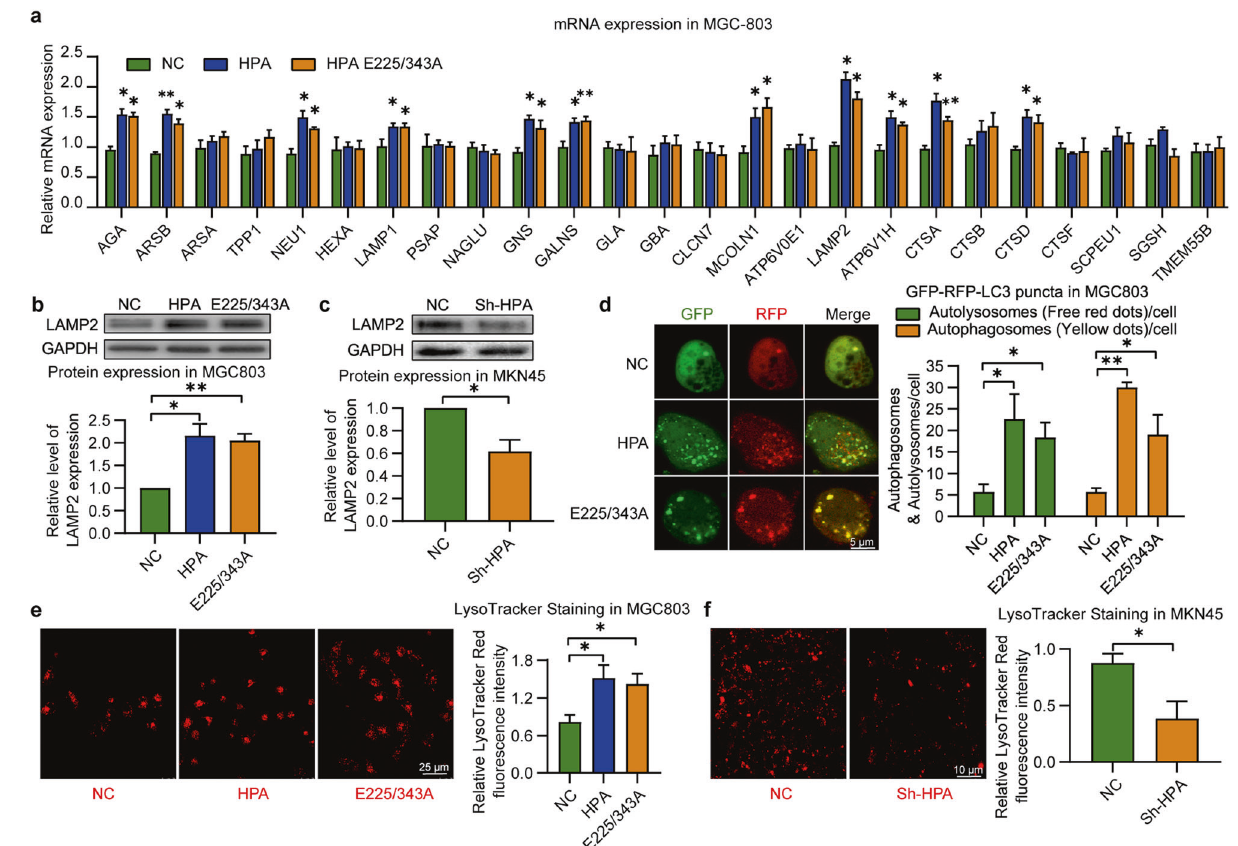
Fig. 4 Wild-type and mutant HPA stimulate autolysosome formation in MGC803 cells. a lysosome biogenesis-related gene expression in MGC803 cells overexpressing native or mutant HPA and subjected to starvation for 4 h. b representative image of LAMP2 protein in MGC803 cells overexpressing native or mutant HPA and subjected to starvation for 4 h. c representative immunoblot analysis of LAMP2 in MKN45 cells subjected to HPA gene knockdown and starvation. d formation and quanti fi cation of GFP-RFP-LC3 puncta in MGC803 cells overexpressing native or mutant HPA in the absence of nutrients. Imaging of lyso-Tracker Red labeled lysosomes in starved MGC803 cells overexpressing native or mutant HPA ( e ), and in MKN45 cells subjected to HPA-knockdown and starvation ( f ). * P < 0.05, ** P < 0.01 versus the NC